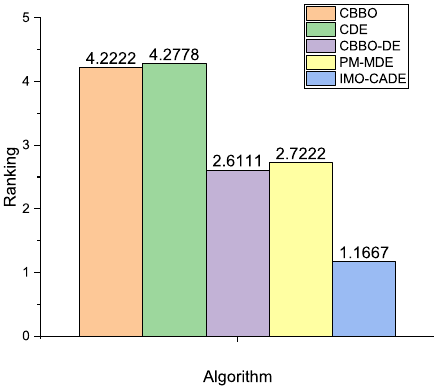
Figure 3. Average rankings of different methods obtained by the Friedman test for the OPA with the reported results under i.i.d. observations, where the p -value computed by Iman and Daveport test is 2.15 × 10 − 7